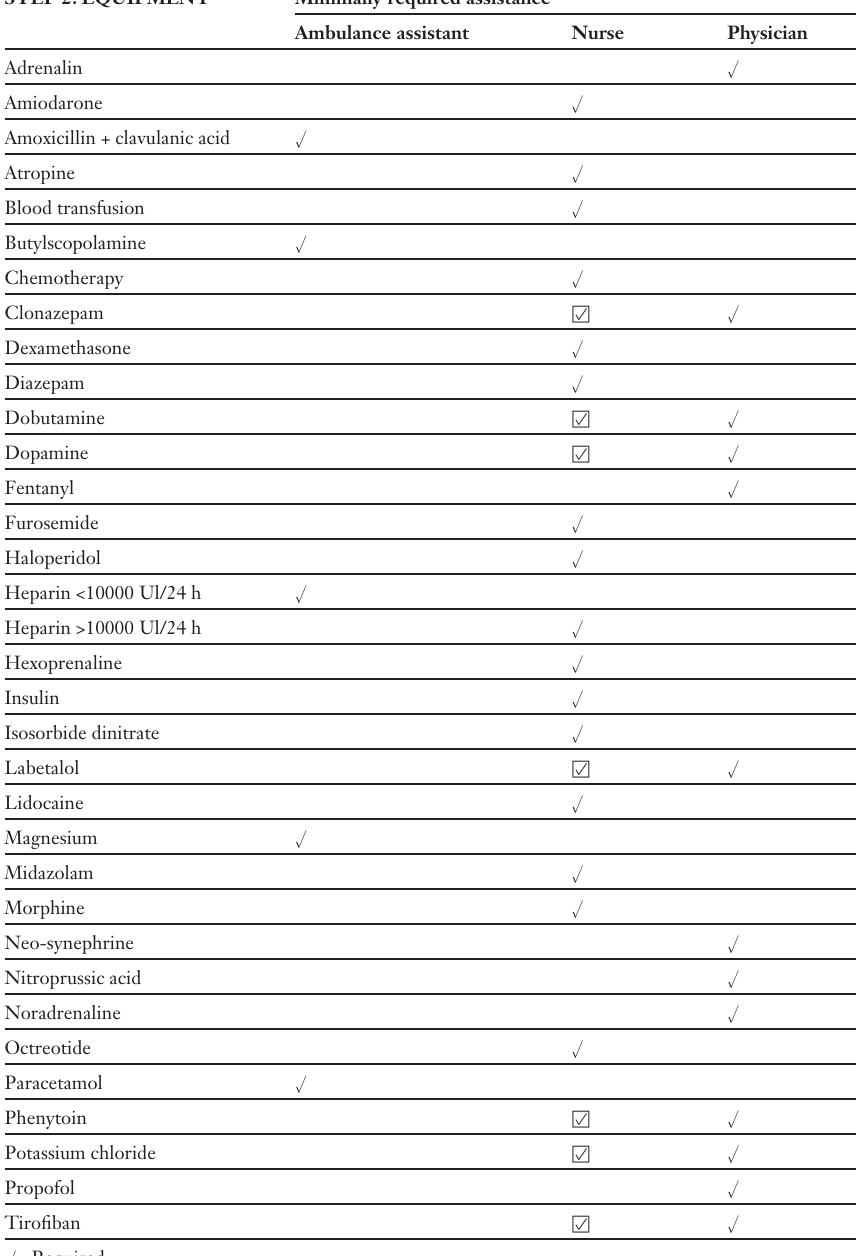
Algorithm for assessment of patient’s required assistance by medication